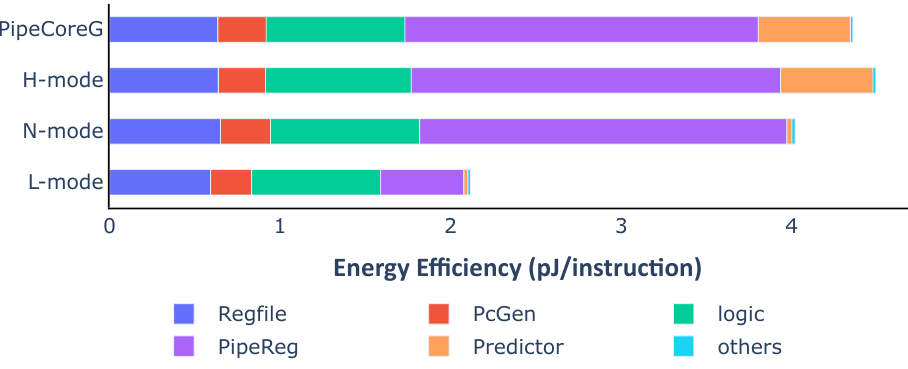
Figure 13. Average energy consumption and distribution of the variable processor in different modes.